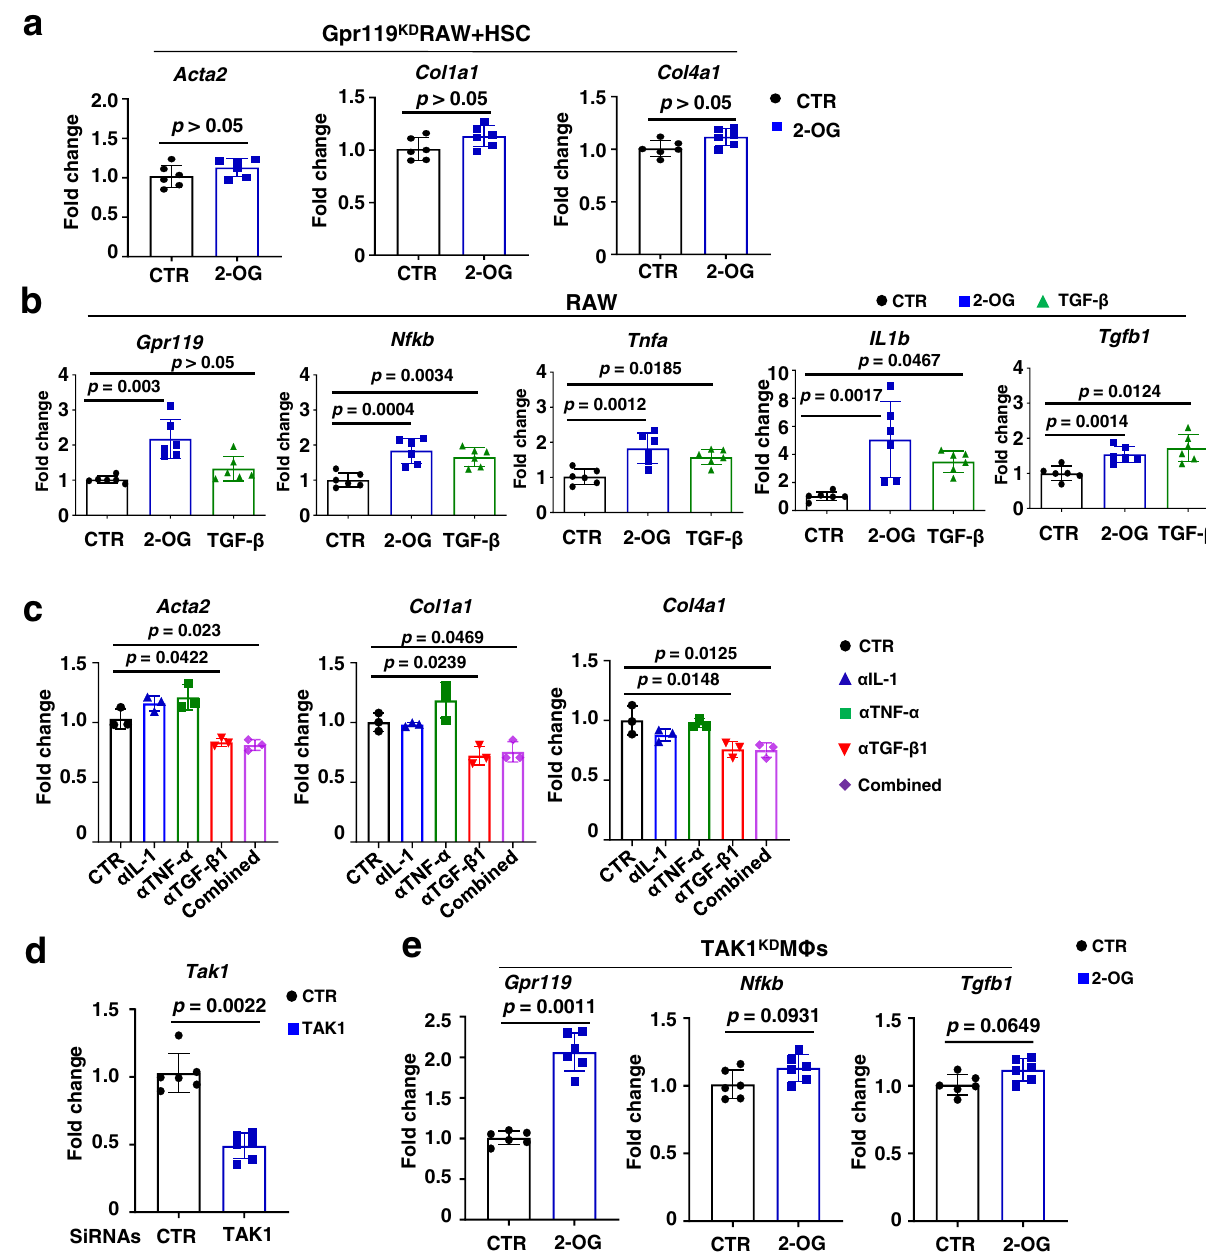
Fig. 7 | 2-OG is unable to activate GPR119-knockdown M Φ s and their co- culturedHSCs.a Gpr119 -knockdowninM Φ sblocks2-OG-inducedactivationofthe co-cultured HSCs. qPCR did not detect the 2-OG-induced upregulation of genes Acta2 , Col1a1 , and Col4a1 in HSCs co-cultured with Gpr119 -knockdown RAW264.7 cells induced by siRNAs. b 2-OG stimulation induces increased production of GPR119 and proin fl ammatory cytokines in RAW264.7 cells. qPCR detected increased mRNA expression of Gpr119 , Nfkb , Tnfa , IL1b , and Tgfb1 in 2-OG- stimulated RAW264.7 cells for 24h. TGF- β 1 (10ng/mL) was used as a positive control. c Anti-TGF- β 1 inhibits 2-OG-induced HSC activation co-cultured with RAW264.7 cells. qPCR analysis showed that 2-OG stimulation upregulated Acta2 , Col1a1 ,and Col4a1 inHSCsco-culturedwithRAW264.7cells,whichwasinhibitedby